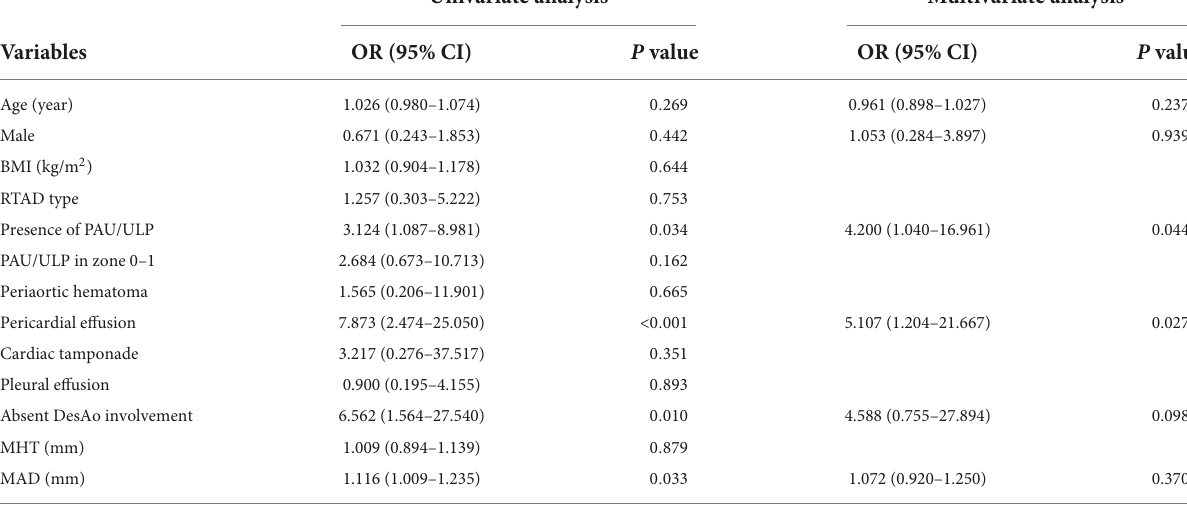
TABLE 2 Multivariate logistic regression analysis for predicting aortic events. Univariate analysis Multivariate analysis